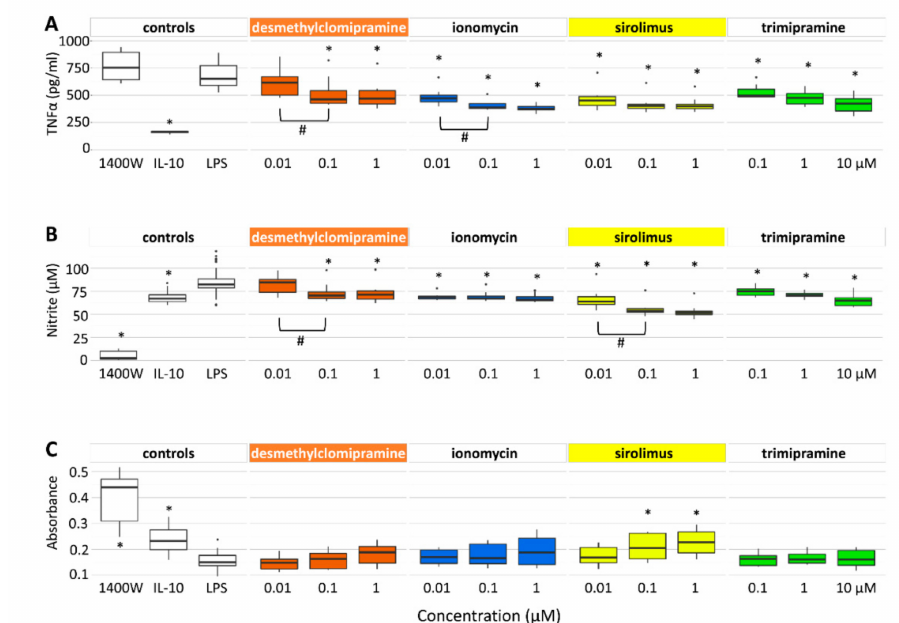
Figure 2. In vitro validation of anti-inflammatory, anti-oxidant and neuroprotective e ff ects of test compounds. ( A ) Treatment e ff ect on neuroinflammation was assessed by measuring TNF α levels in the culture medium as a monitoring biomarker. All test compounds reduced TNF α and the e ff ect was dose-dependent in the cases of desmethylclomipramine and ionomycin. ( B ) The treatment e ff ect on nitric oxide –mediated neurotoxicity was assessed by measuring nitrite levels in the culture medium as a monitoring biomarker. All test compounds also reduced nitrite levels and the e ff ect was dose-dependent in the cases of desmethylclomipramine and sirolimus. ( C ) The treatment e ff ect on neuronal viability was assessed by measuring microtubule-associated protein 2-originated signals in the culture medium as a monitoring biomarker. Only sirolimus improved neuronal viability. Experiments were performed twice, each including quadruplicates of each test compound and